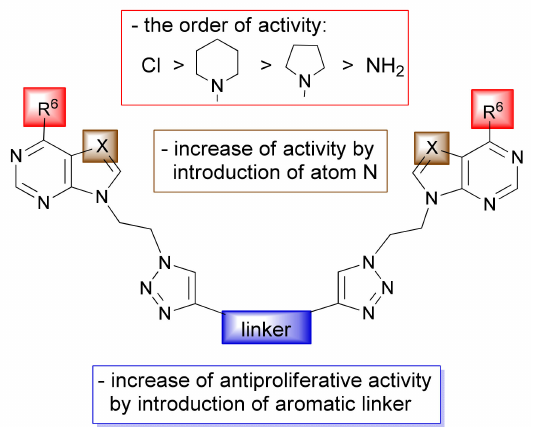
Figure 5. Structure–activity relationship for antiproliferative activity of bis- and mono-pyrrolo[2,3- d ]pyrimidine and purine